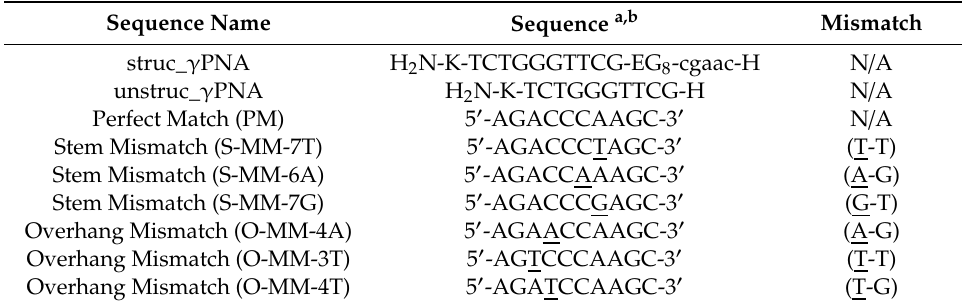
Table 1. GammaPNA ( γ PNA) probes and DNA targets.